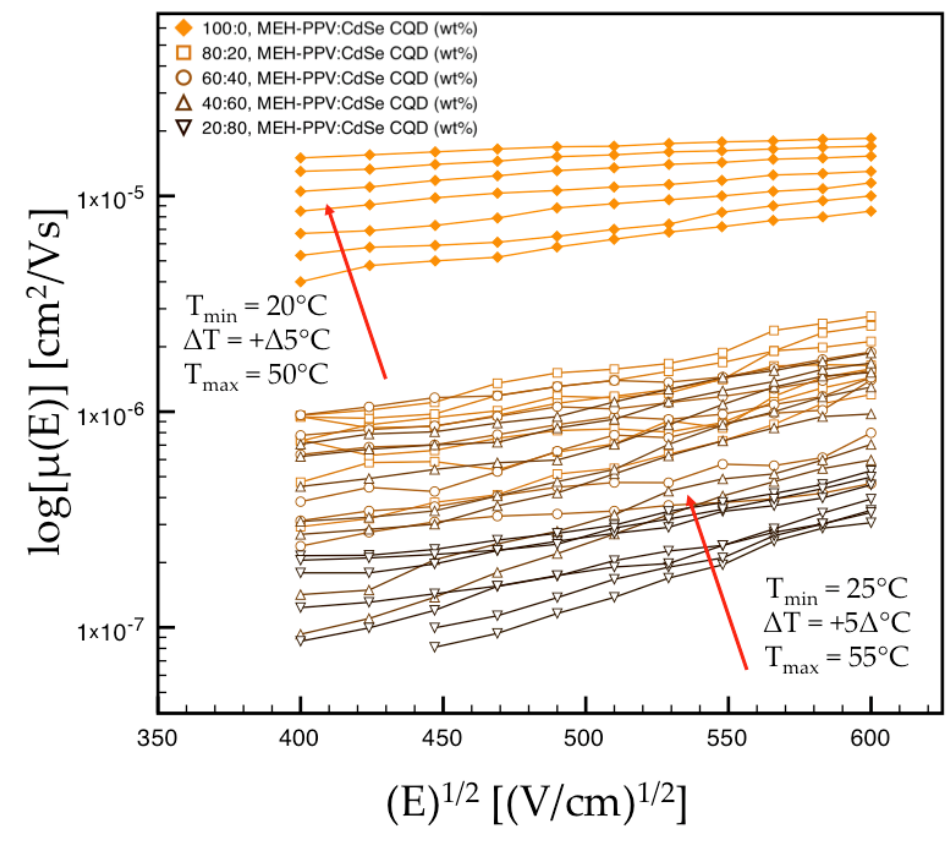
Figure 3. Hole drift mobility vs . temperature and electric field for nanocomposite thin films with different MEH-PPV:CdSe CQD